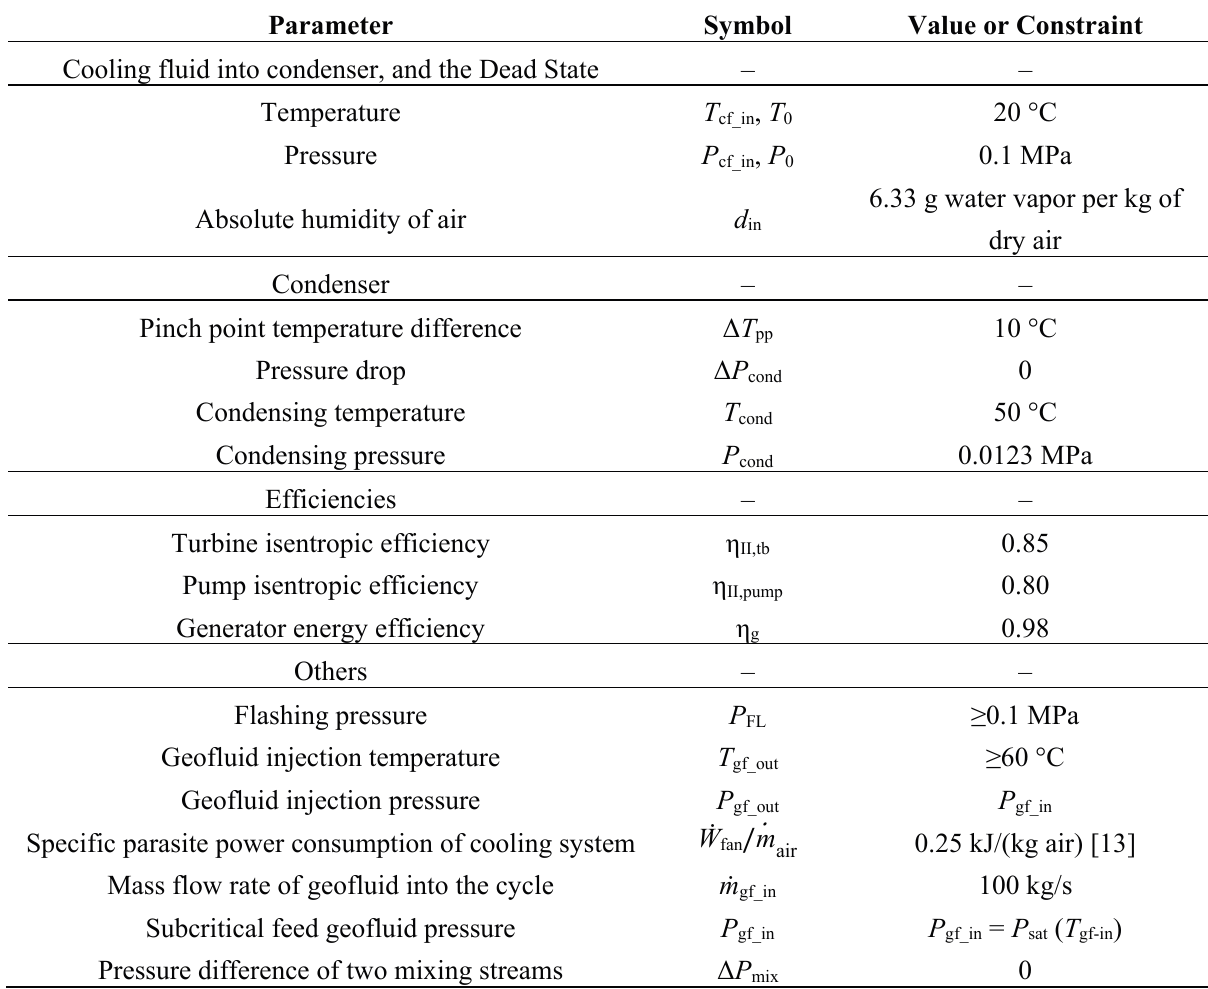
Table 1. Inputs and constraints of thermodynamic